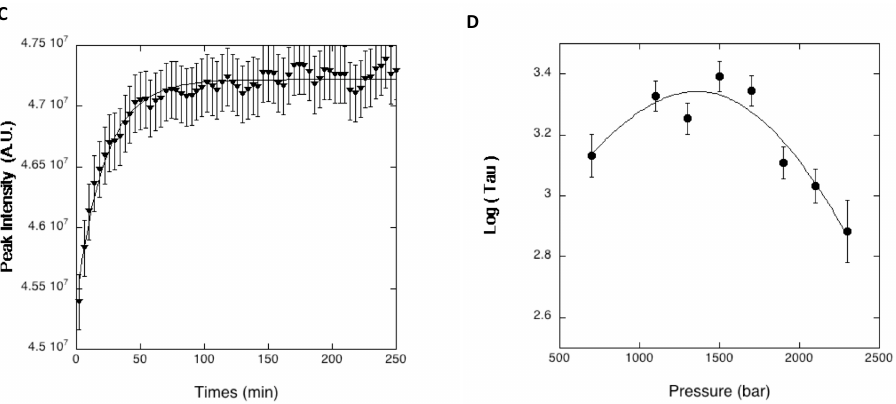
Figure 7. P-jump experiments followed by high-pressure 1D proton NMR. ( A ) Stacked plot of the 1D proton NMR spectra recorded on DEN4-ED3 after a positive 200 bar P-jump (1700 to 1900 bar). Only the region of the methyl resonances is reported. The arrow indicates the resonance corresponding to unfolded methyl groups (CH3 (U)), used as a probe to measure the relaxation rates τ ( p ). ( B ) Time evolution of the unfolded methyl resonance (CH3 (U)) after positive 200 bar P-jumps realized between different pressures (final pressures are reported in the insert). ( C ) Example of fit obtained for the 1700 to 1900 P-jump: the data points were fitted with an exponential growth to obtain the values of τ . ( D ) The fit with Equation 3 of the chevron plot of log( τ ) versus pressure allows extraction of the folding and unfolding global rate constants k u and k f , as well as the apparent global residue-specific activation volume of folding ( ∆ V f‡ ) (see Material and Methods).